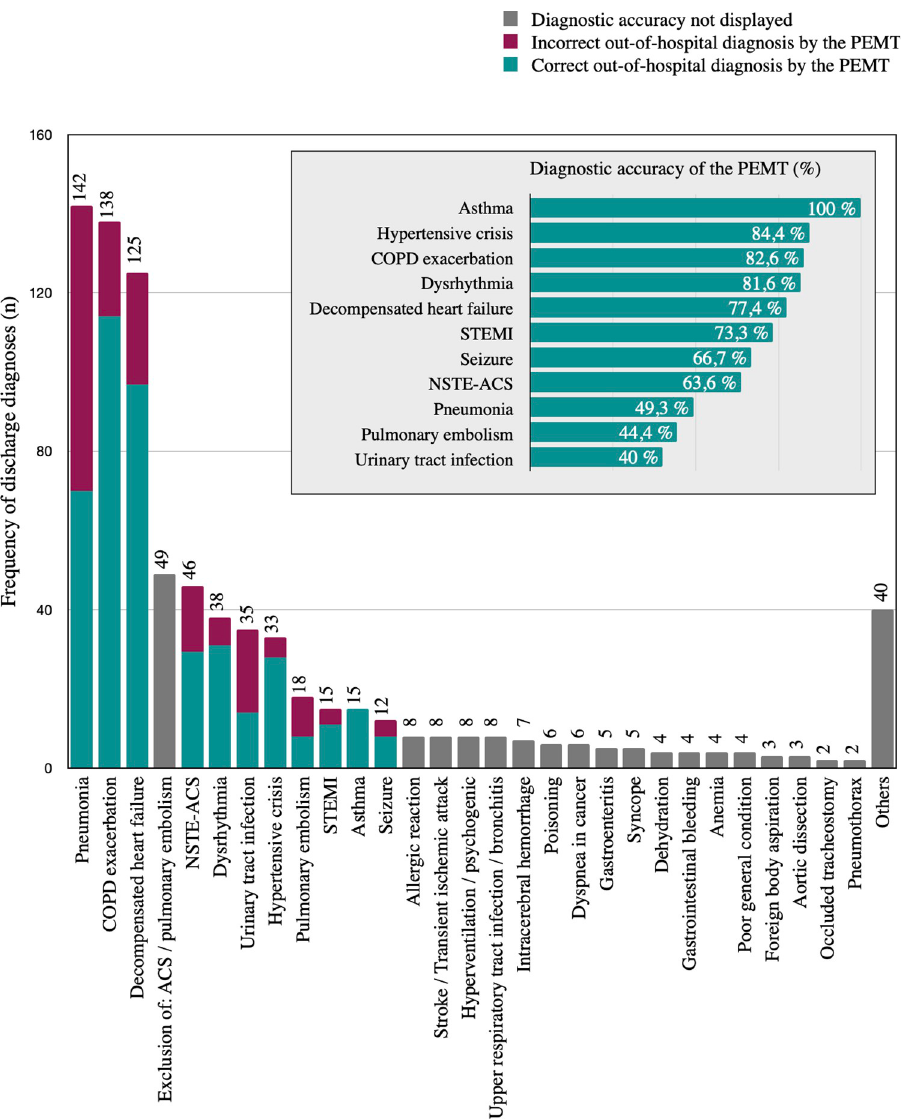
segment elevation ACS; STEMI: ST-elevation myocardial infarction; total of number of discharge diagnoses made: 793.